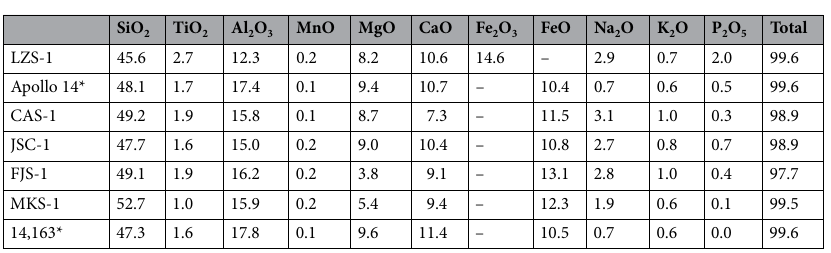
Table 2. Major element composition of LZS-1 and compared with CAS-1, JSC-1, FJS-1, MKS-1 lunar soil simulant, and Apollo 14 lunar regolith 5 . Apollo 14*, average chemical composition of lunar regolith sampled by astronauts at Apollo 14 landing sites. Data of Apollo 14* and 14163* were cited from Heiken et al. (1991) 23 , data of JSC-1 was cited from McKay et al. (1993, 1994) 18,24 .